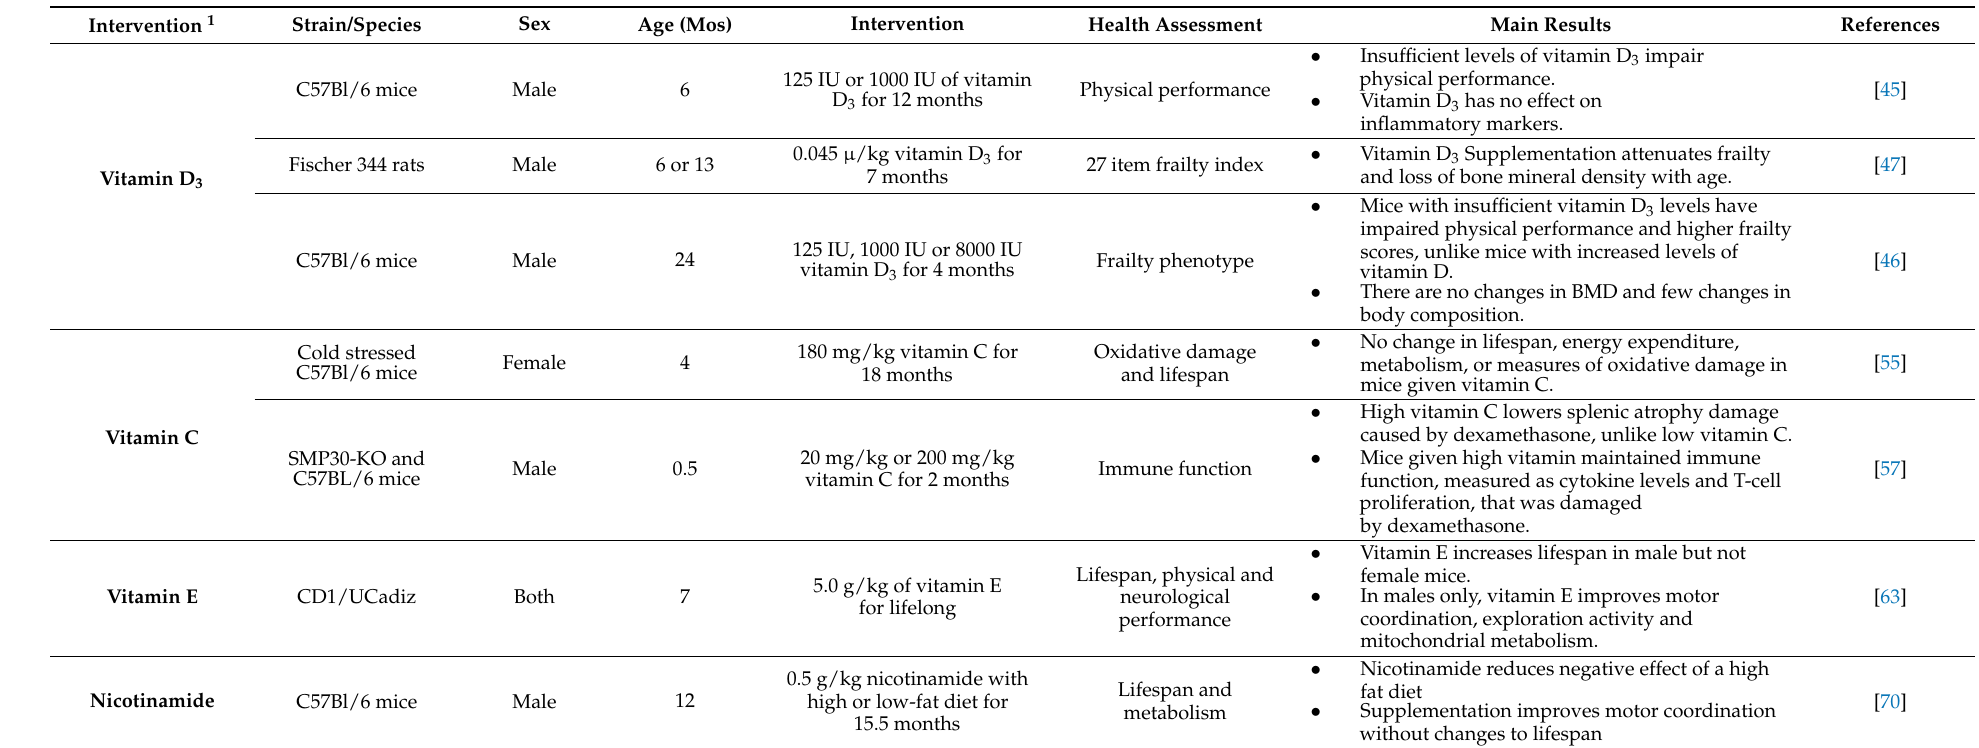
Table 1. Vitamin interventions to improve health and decrease